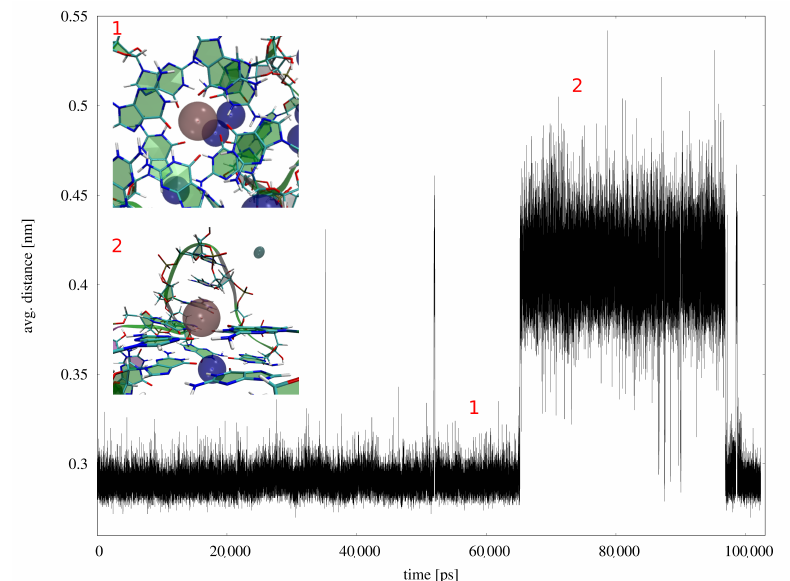
Figure A4. The stability of the seq2 quadruplex, as expressed by the average distance between K + and the carbonyl oxygens of the eight guanines coordinating it. Inlet 1—the stable GQ core structure. Inlet 2—K + (dark-pink sphere) left the GQ core due to the repulsion of Na + (dark-blue sphere) at the entrance of the GQ core, and due to the deformation of the GQ core (see the text of Appendix B.2 and Figure A6 for